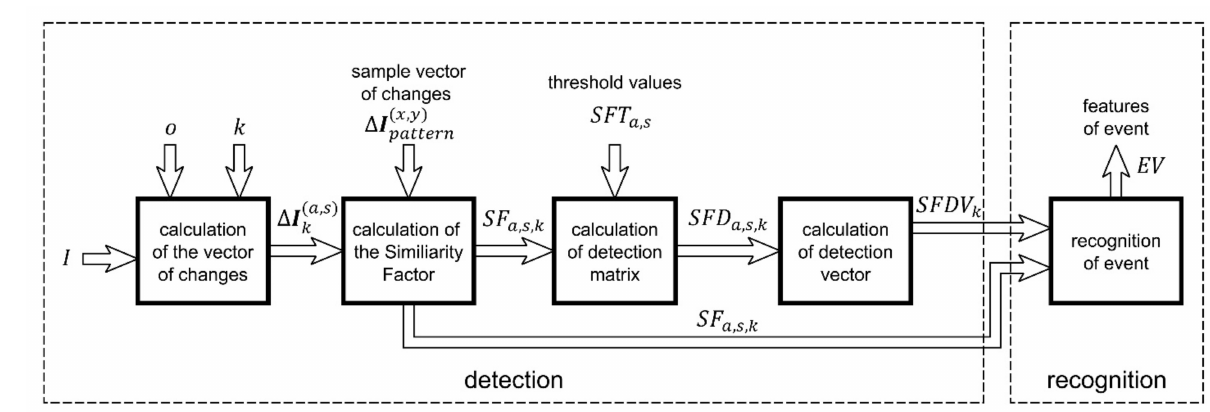
Figure 8. Current signature calculation